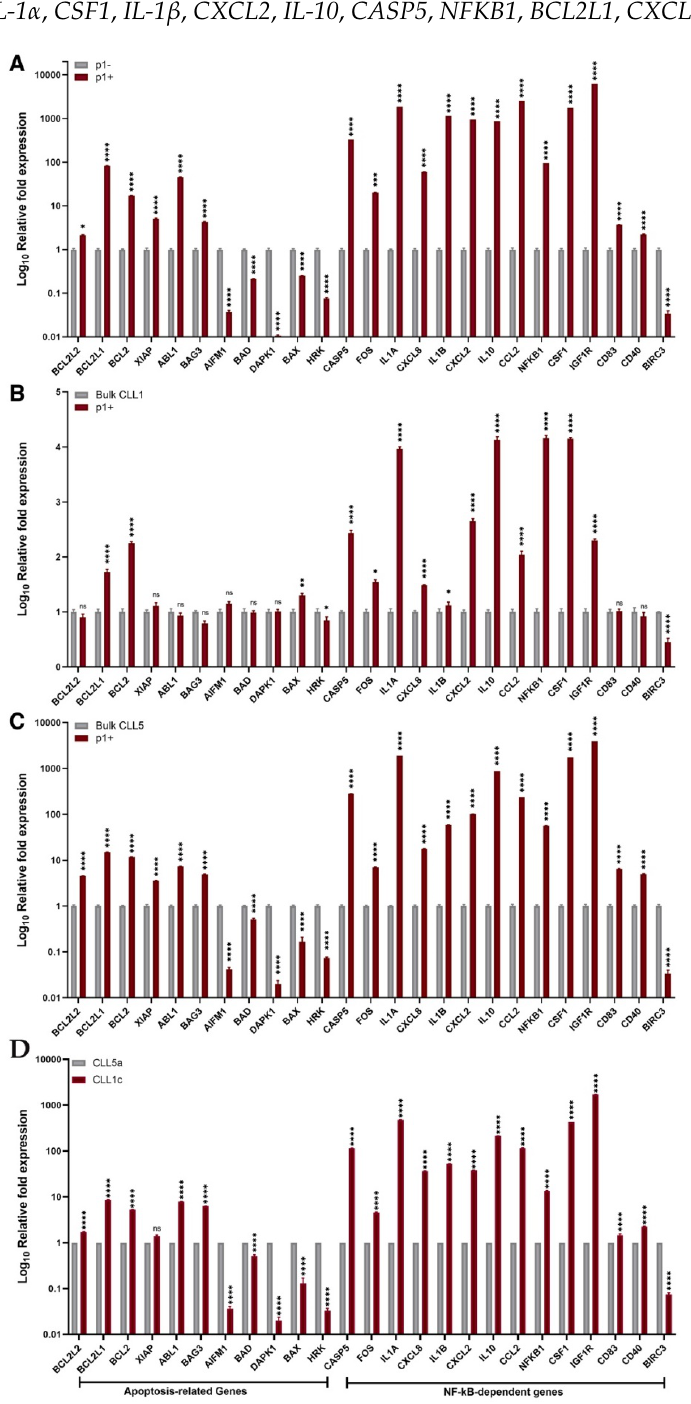
Figure 4. Expression levels of the most deregulated genes comparing p1-positive (p1+) cells with respect of p1-negative ( p− ) cells ( A ), bulk cells of CLL1c patient ( B ), and bulk cells of CLL5a patient ( C ), and comparing bulk cells of CLL1c with respect to CLL5a ( D ). Data are reported as folds ± SD of IGHV 1-69 p1+ cells versus non- IGHV 1-69 p1- cells ( A ), bulk CLL1c ( B ), and bulk CLL5a ( C ), and as folds ± SD of bulk CLL1c versus CLL5a ( D ). Statistical significance was calculated using ordinary one-way ANOVA and Bonferroni’s test of multiple comparisons. ns: not significative; * p ≤ 0.1; ** p ≤ 0.01; *** p ≤ 0.001; **** p ≤ 0.0001 of three independent